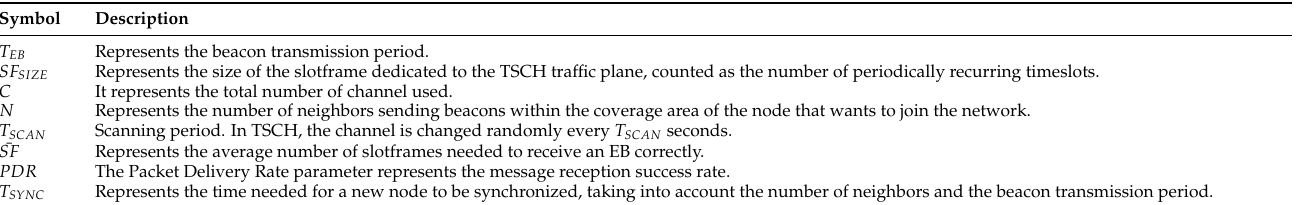
Table 1. TSCH analytical model